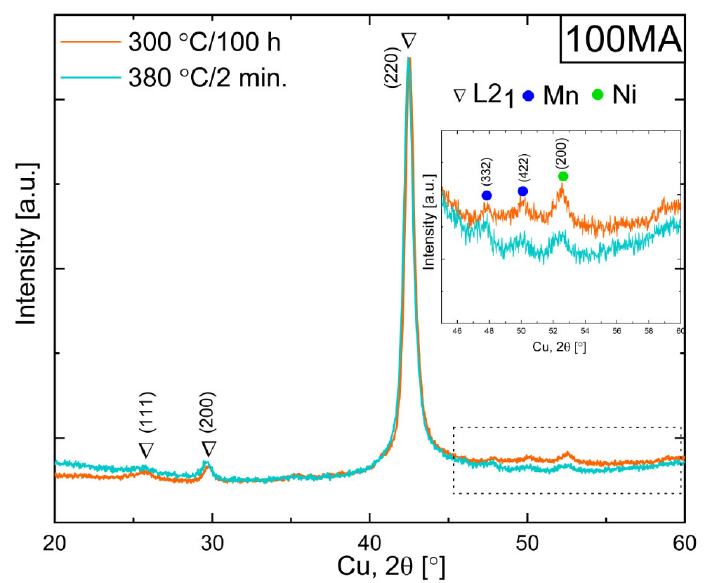
Figure 8. XRD patterns of powders after 100 h mechanical alloying and annealing at 300 °C for 100 h and at 380 °C for 2 min.